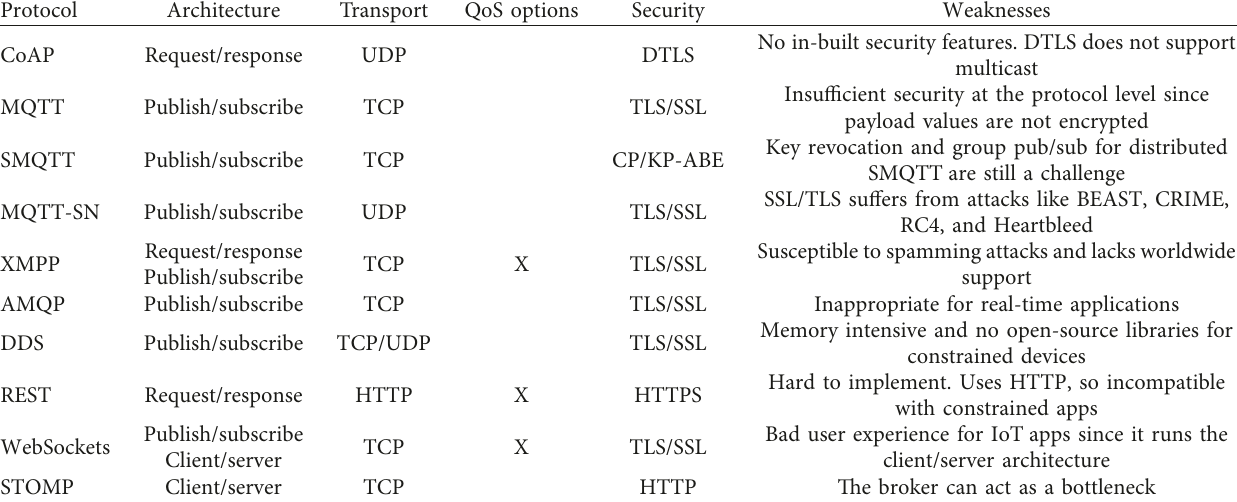
Table 3: Differences and problems with application layer